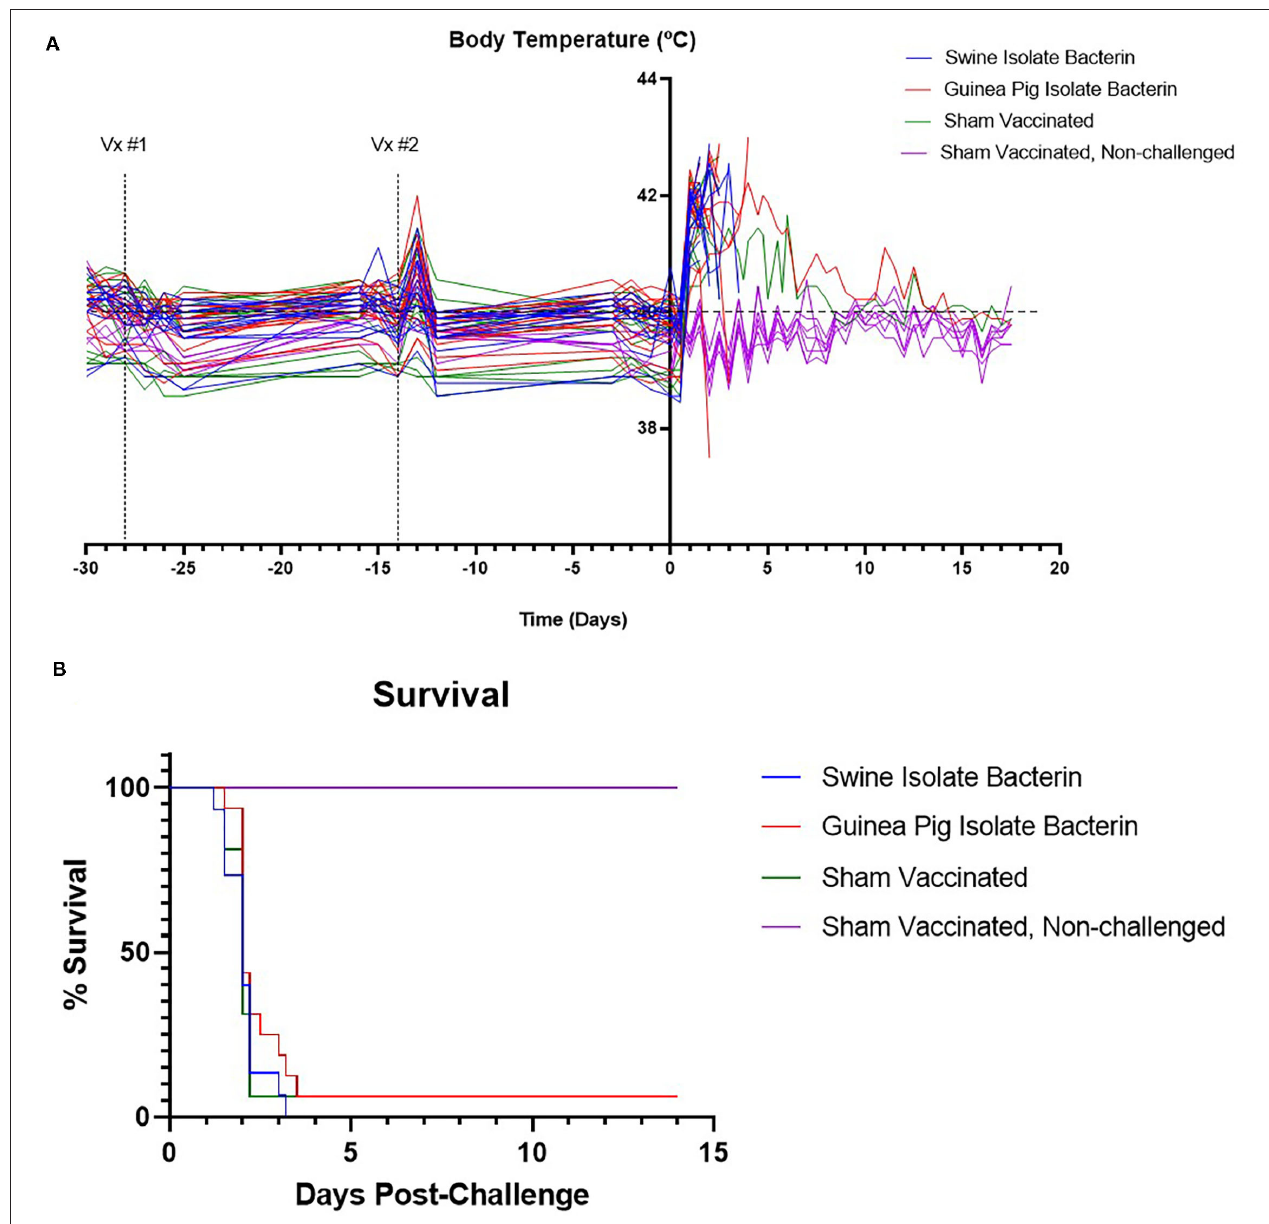
FIGURE 2 | Body temperature and survival following challenge with SEZ. The temperatures of animals are plotted in (A) . All animals developed a fever following challenge with SEZ. The upper limit for normal pig body temperature is marked by the dashed line (40 ◦ C). Survival percent following challenge with SEZ is plotted in (B) . No differences in survival were observed between SEZ challenged groups regardless of vaccination